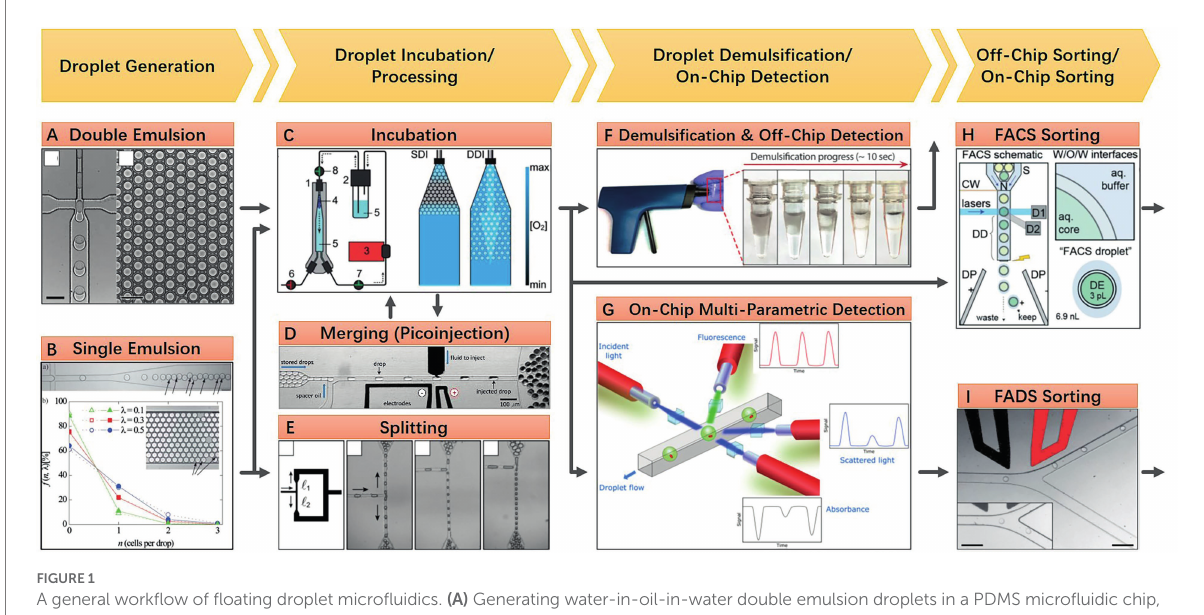
FIGURE 1 A general workflow of floating droplet microfluidics. (A) Generating water-in-oil-in-water double emulsion droplets in a PDMS microfluidic chip, the monodispersed double emulsion droplets are compatible with a commercial flow cytometer (Reprinted from Bauer et al., 2010 with the permission of Royal Society of Chemistry); (B) Generating water-in-oil single emulsion droplets in a PDMS microfluidic chip, individual cells are encapsulated during droplet generation and distribution of cells in droplets follows a Poisson distribution. The monodispersed single emulsion droplets are more flexible to be handled and processed (Reprinted from Köster et al., 2008 with the permission of Royal Society of Chemistry); (C) A customized off-chip droplet incubator with enhanced oxygen supply (Reprinted from Mahler et al., 2015 with the permission of Royal Society of Chemistry); (D) An electrically induced droplet merging method called picoinjection for selective adding new reagents into droplets (Reprinted from Abate et al., 2010 with the permission of National Academy of Sciences); (E) A geometry induced droplet splitting method for removing partial contents with desired ratio (Reprinted from Link et al., 2004 with the permission of American Physical Society and the author); (F) An electric induced droplet demulsification method for downstream treatments after droplet processing (Reprinted from Karbaschi et al., 2017 with the permission of AIP Publishing); (G) On-chip multi-parametric detection after droplet incubation (Reprinted from Hengoju et al., 2020 with the permission of AIP Publishing); (H) Off-chip sorting of double emulsion droplets using commensal flow cytometer (Reprinted from Brower et al., 2020 with the permission of Royal Society of Chemistry); (I) On-chip sorting of single emulsion droplets using microfluidic sorter (Reprinted from Baret et al., 2009 with the permission of Royal Society of